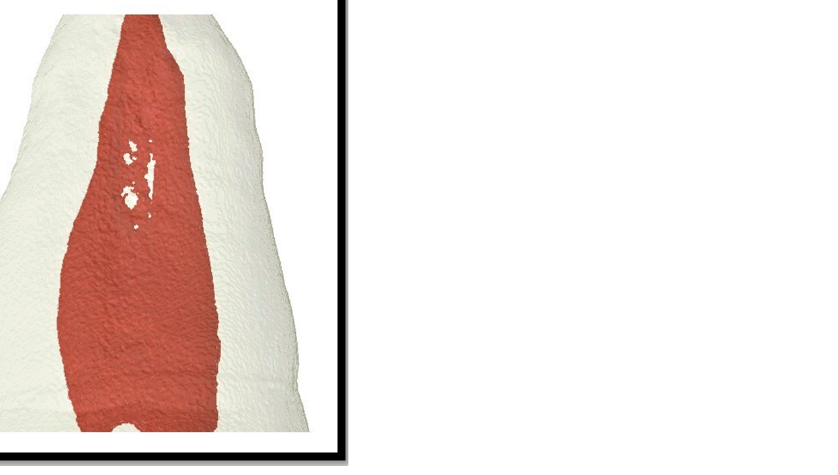
Figure 14. Micro-CT image showing the middle third location of the isthmus.